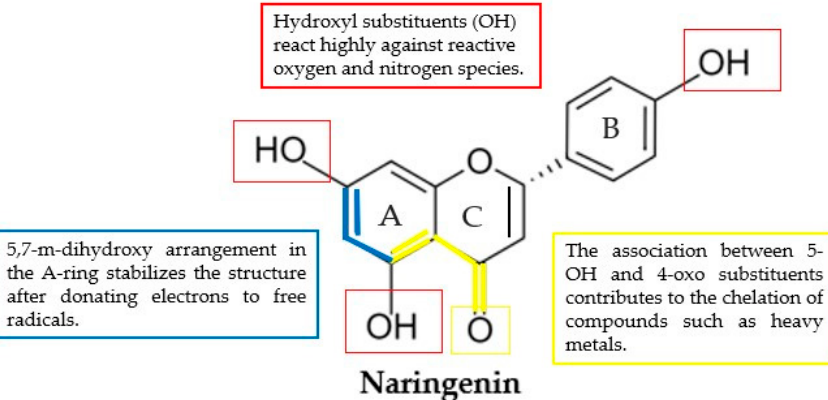
Figure 2. Naringenin: the relationship between antioxidant activity and structure. In red: Hydroxyl substituents (OH) react highly against reactive oxygen and nitrogen species. In blue: 5,7-m-dihydroxy arrangement in the A-ring stabilizes the structure after donating electrons to free radicals. In yellow: The association between 5-OH and 4-oxo substituents contributes to the chelation of compounds such as heavy metals.